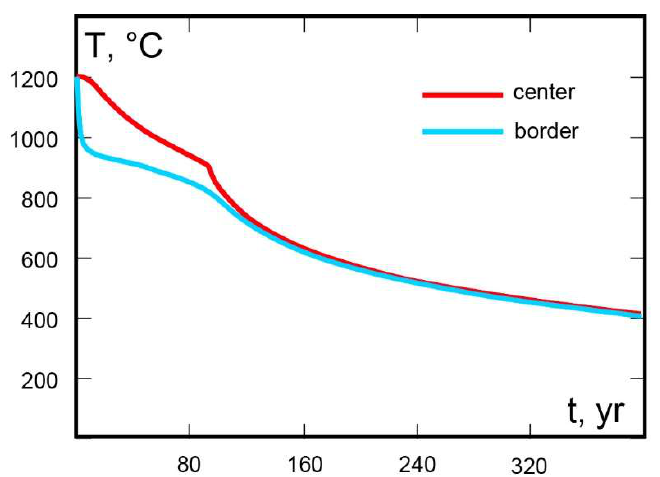
Figure 9. T–t diagram showing the cooling history simulated in the center and in the border of a dyke, by means of a numeric thermal model in Stella ® code. The dyke has a thickness of 40 m, in accordance with Carella [38] cross-section (Figure 1b). The cooling path of the border is related to a point at a distance of 2 m from the contact with the wall rock. Initial temperatures of 1200 °C and 100 °C are assumed for magma and wall rocks, respectively. Thermal diffusivity is fixed at 8.3 × 10 −7 m 2 /s. Finally, a value of 600 kJ/kg is assumed for the latent heat of crystallization in the T interval of 1200–900 °C.